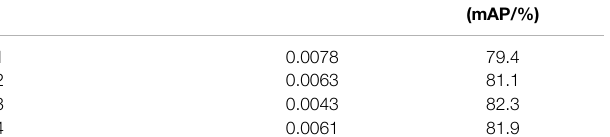
TABLE 4 | Comparison of lightweight graph convolution training batches for 200 times. Convolutional layer number